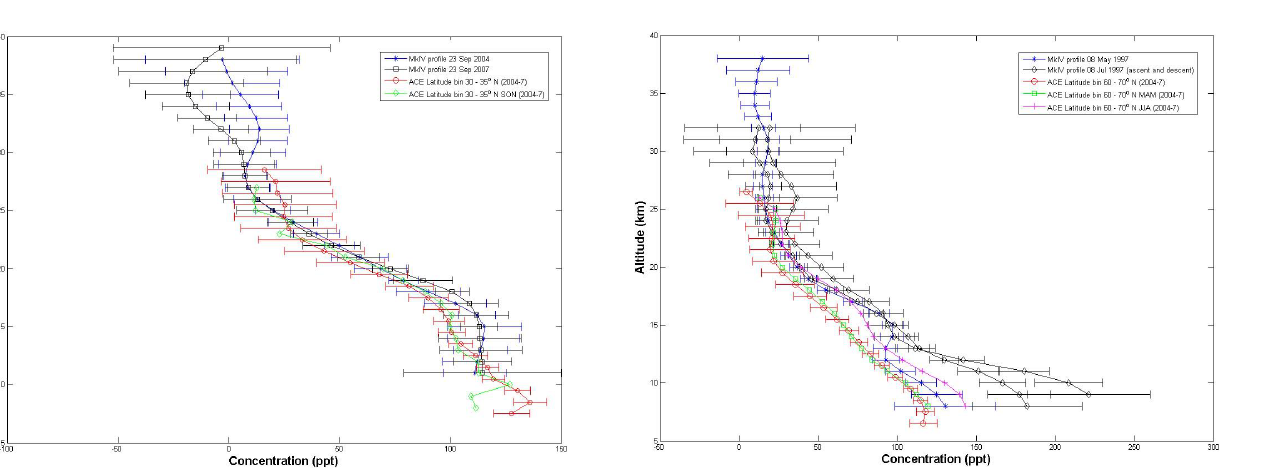
Fig. 5. The average carbon tetrachloride volume mixing ratio profile for the latitude bin 30–35 ◦ N (red line with circles), as well as the seasonal SON (September-October-November) latitude bin (green line with diamonds) for the same region (30–35 ◦ N), from the ACE mission between February 2004 and August 2007 is displayed and compared with two balloon profiles from near Ft. Sumner, New Mexico (33–35 ◦ N) obtained by Toon et al. (unpublished data) using a MkIV FTS instrument on the 23 September 2004 (blue line with asterisks) and 23 September 2007 (black line with squares).